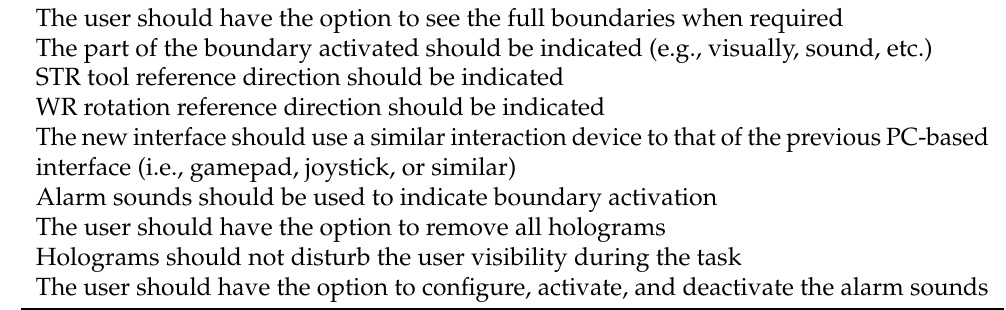
Table 1. Application